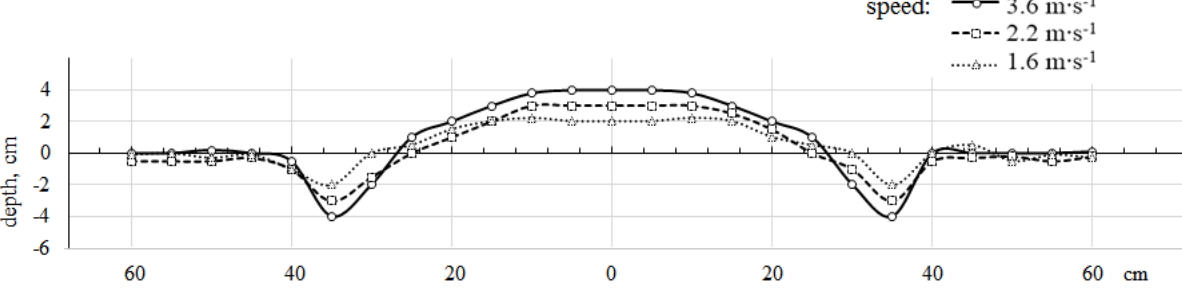
Figure 7. The cross section of loosed soil surface of tramline.